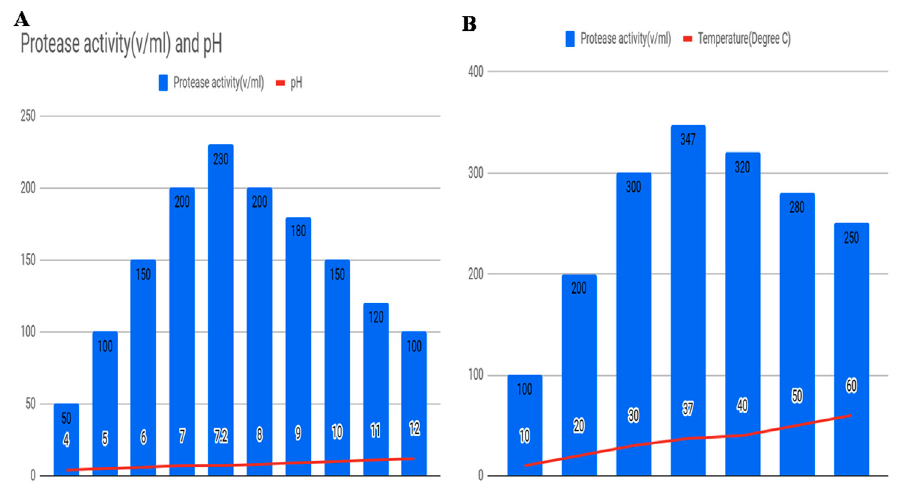
Fig. 5. Optimization of protease activity with respect to (A) varying pH, and (B) varying temperature for the selected bacterial